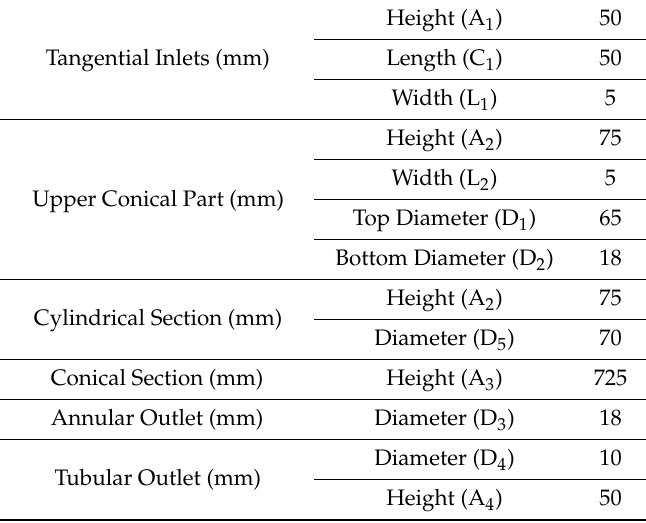
Table 1. Dimensional parameters of filtering and conventional cyclonic separators.